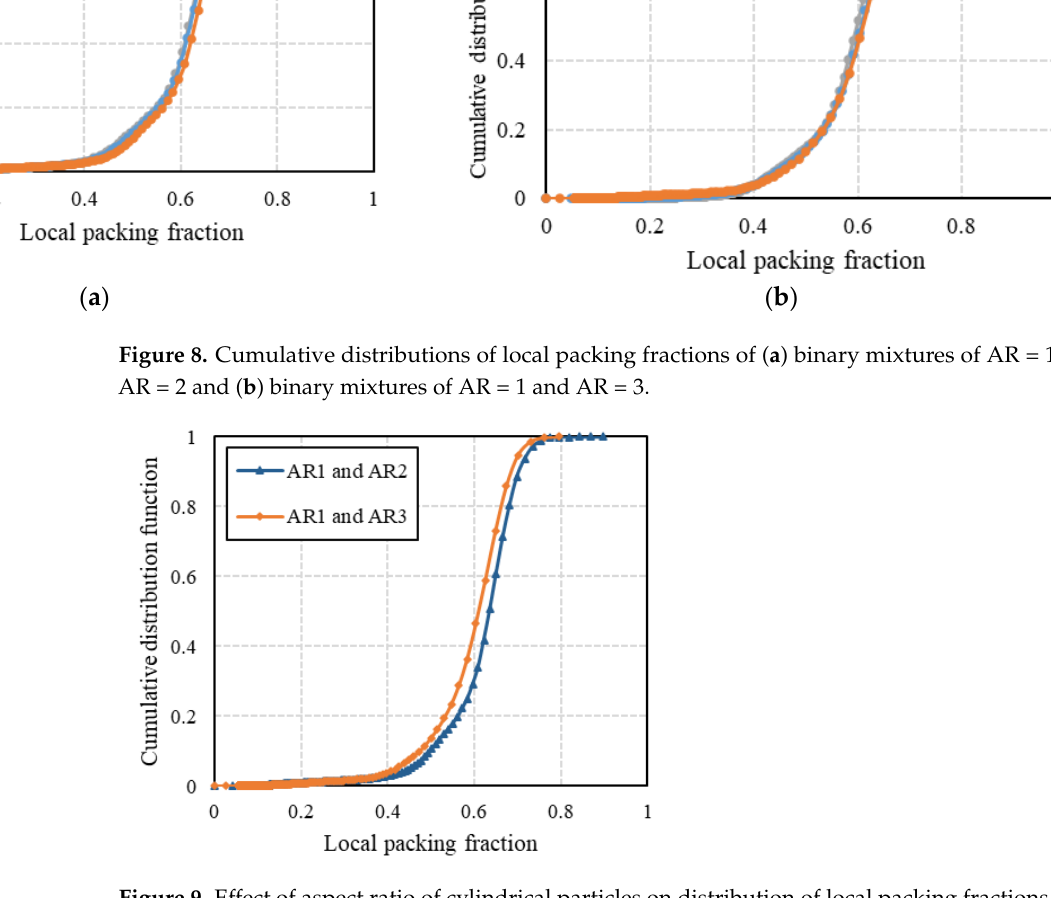
Figure 9. Effect of aspect ratio of cylindrical particles on distribution of local packing fractions.